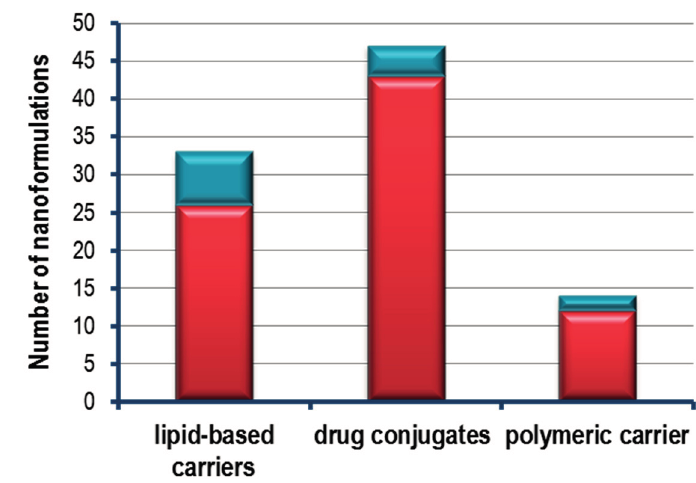
Figure 20. Number of heterocyclic compounds nanoformulations currently in clinical trial (red bars) and FDA approved (blue bars) for cancer therapy. Lipid based carriers nanoformulations include liposomes; Drug conjugates include antibody-drug conjugates and polymer-drug conjugates; Polymeric carriers include nanoparticle albumin bound technology, polymeric micelles and polymeric nanoparticles